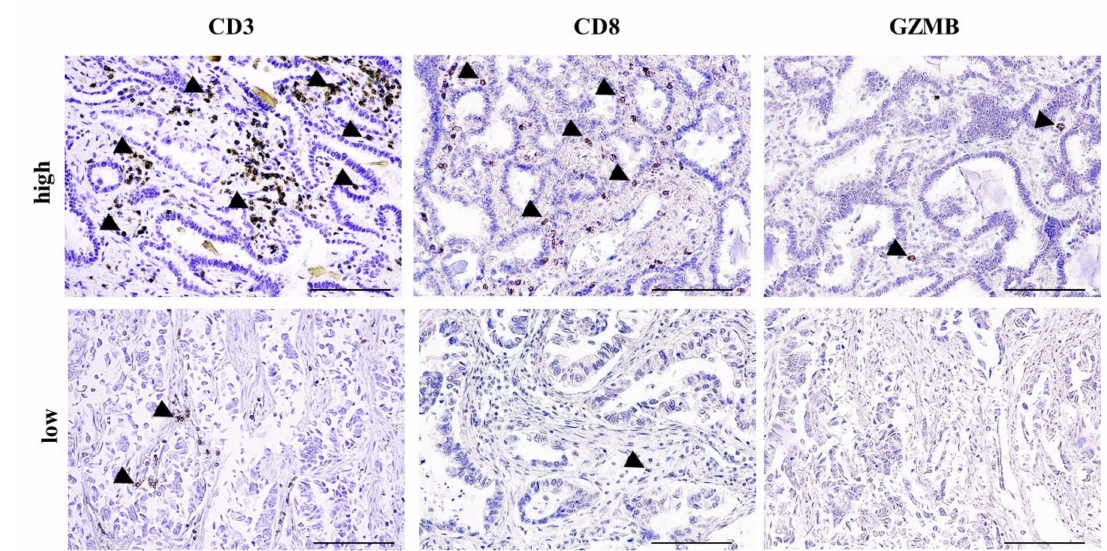
Figure 1. High-tumor-infiltrating lymphocyte (TIL) and low-TIL infiltrate. Representative photos with high and low CD3, CD8 and granzyme B (GZMB) infiltrate in two non-small cell lung cancer (NSCLC) patients. Arrowheads depict positive immunostaining. Scale bar: 100 µ